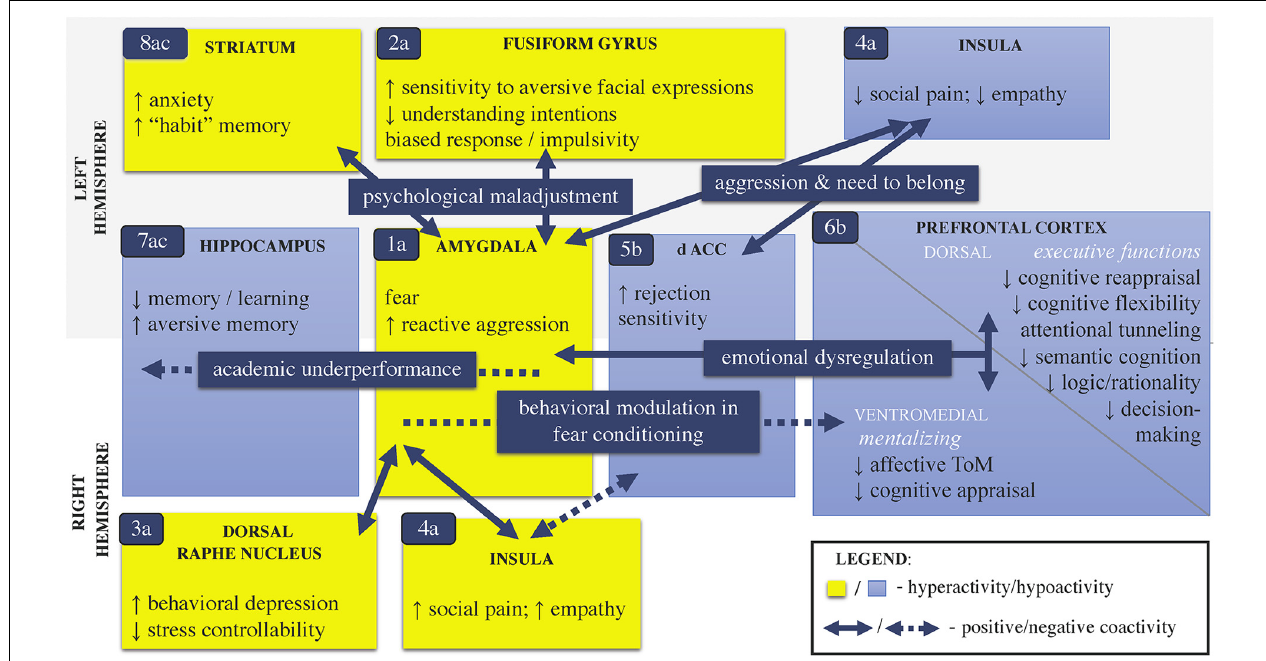
FIGURE 3 | Major brain circuits associated with childhood stress psychopathology. Note: This schematic model integrates the major cerebral circuits (1–8) of cognitive and emotional convergence in stress neuroactivity that can be associated with childhood psychopathology. The model is a simplified syntax of the evidence in: [a] general psychological stress; [b] childhood BV; and [c] early life adversity. [a] The brain dynamics stem from (1) a hyperactivated amygdala following fear conditioning, which is a common neural response to an acute psychological stressor (i.e., “alarm-to-threat” stage, Palamarchuk and Vaillancourt, 2021). The magnitude of the amygdalar stress-reactivity can be mediated by the activity of the (2) fusiform gyrus, (3) dorsal raphe nucleus, and (4) anterior insula. [b] Hypothetically, the amygdalar overactivity can suppress the (5) dorsal/rostral ACC, which further can lead to (6) hypofunctioning of the vmPFC and thus impair mentalizing in young targets of BV. [a,c] Generally, in intense/chronic psychological stress, the amygdalar hyperactivity can (7) alter hippocampal memory encoding and (8) promote striatum-dependent memorization, which together, exacerbate compromised PFC related to executive functions. If altered PFC has poor inhibitory control over the amygdalar reactivity, a vicious cycle can occur (1 (cid:29) 8). Of note, besides environmentally mediated pathways, childhood BV can also be a risk factor if the maladaptive brain dynamics pre-date the stress. For instance, genetic factors and developmental nuances of greater amygdalar sensitivity to stress and/or immature functions of the PFC (e.g., poor ToM) can increase susceptibility to stress in early life. The cerebral networks potentially display hemispheric lateralization in functions that distinguish pure targets (the right dominance) from bully-victims (the left dominance). Legend : dACC, dorsal anterior cingulate cortex; BV, bullying victimization; ToM, theory of mind; ↑ , increase; ↓ ,